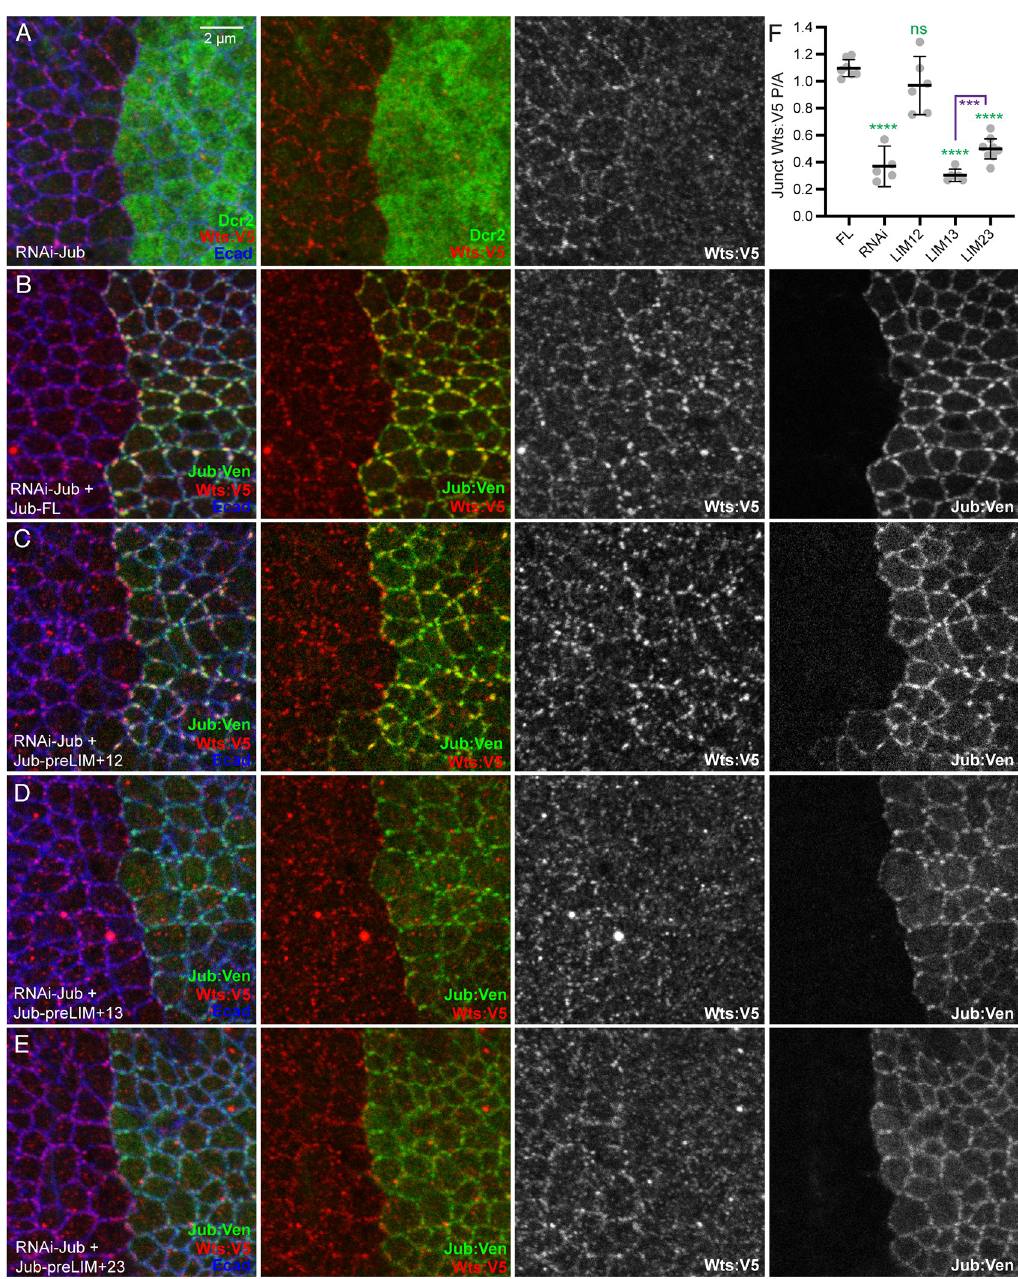
Fig 4. Rescue of junctional Wts by Jub deletion constructs. A-E) Representative wing discs from larvae expressing genomic tagged Wts:V5 (red), hh-Gal4 UAS-Dcr2 and A) UAS-RNAi-jub . B) UAS-RNAi-jub UAS-Jub-FL : msVenus . C) UAS-RNAi-jub UAS-Jub-preLIM+12 : msVenus . D) UAS-RNAi jub UAS-Jub-preLIM+13 : msVenus . E) UAS-RNAi jub UAS-Jub-preLIM+23 : msVenus . All discs are shown at the same magnification (scale bar = 2 μ m). F) Scatter plot showing quantitation of Wts:V5 levels on AJ (defined by Ecad) in posterior cells as compared to the levels in anterior cells, with mean and 95% ci indicated by black bars. Genotypes are indicated by abbreviations at bottom. Numbers of wing discs measured are Jub-FL ) 7, jub RNAi) 5, Jub-preLIM+12 ) 6, Jub-preLIM+13 ) 6, Jub-preLIM+23 ) 8. The significance of differences in expression levels (ANOVA) as compared to UAS-RNAi-jub UAS-Jub-FL : msVenus are indicated by green asterisks, additional selected comparisons are in